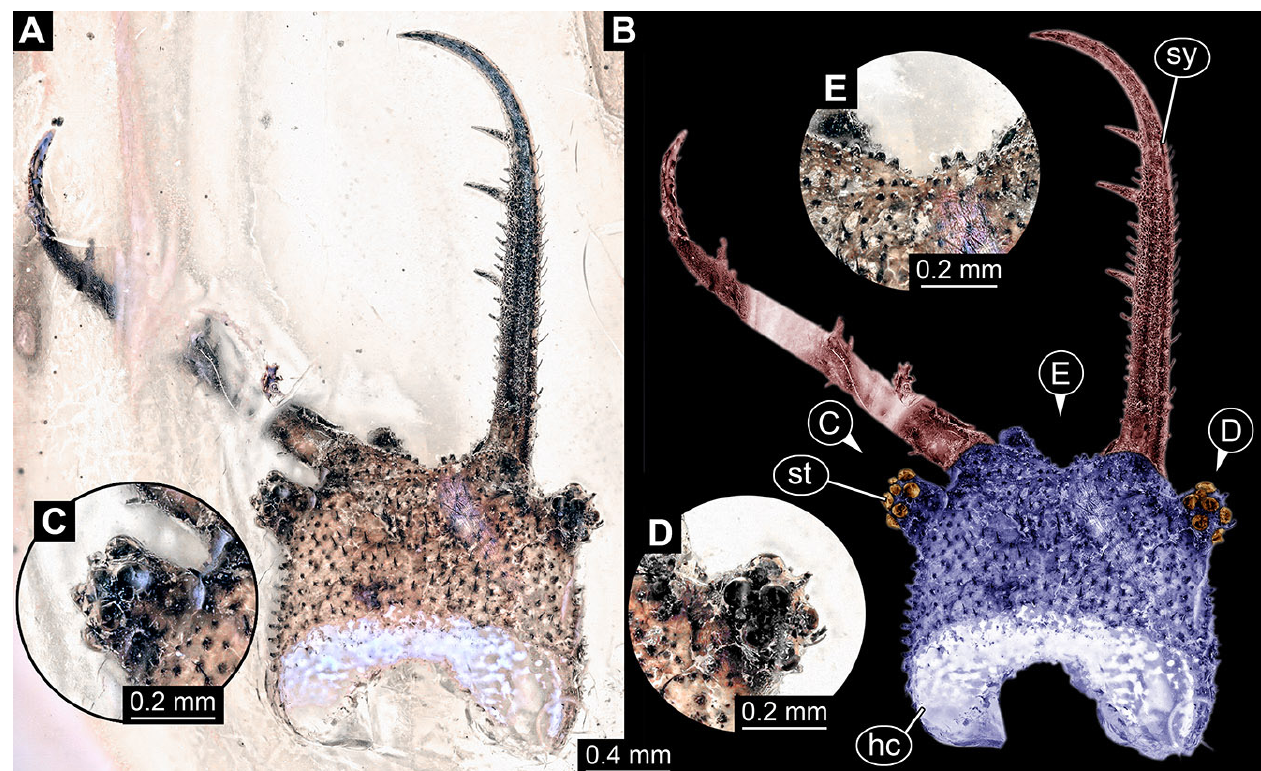
Figure 1. Fossil owllion larva, specimen 3102 (CCGG 2525), Eocene Baltic amber. ( A ) Overview, dorsal. ( B ) Color-marked version of ( A ). ( C ) Close-up on stemmata, left side. ( D ) Close-up on stemmata, right side. ( E ) Close-up on antero-median region of head capsule. Abbreviations: hc = head capsule; st = stemmata; sy = stylet.